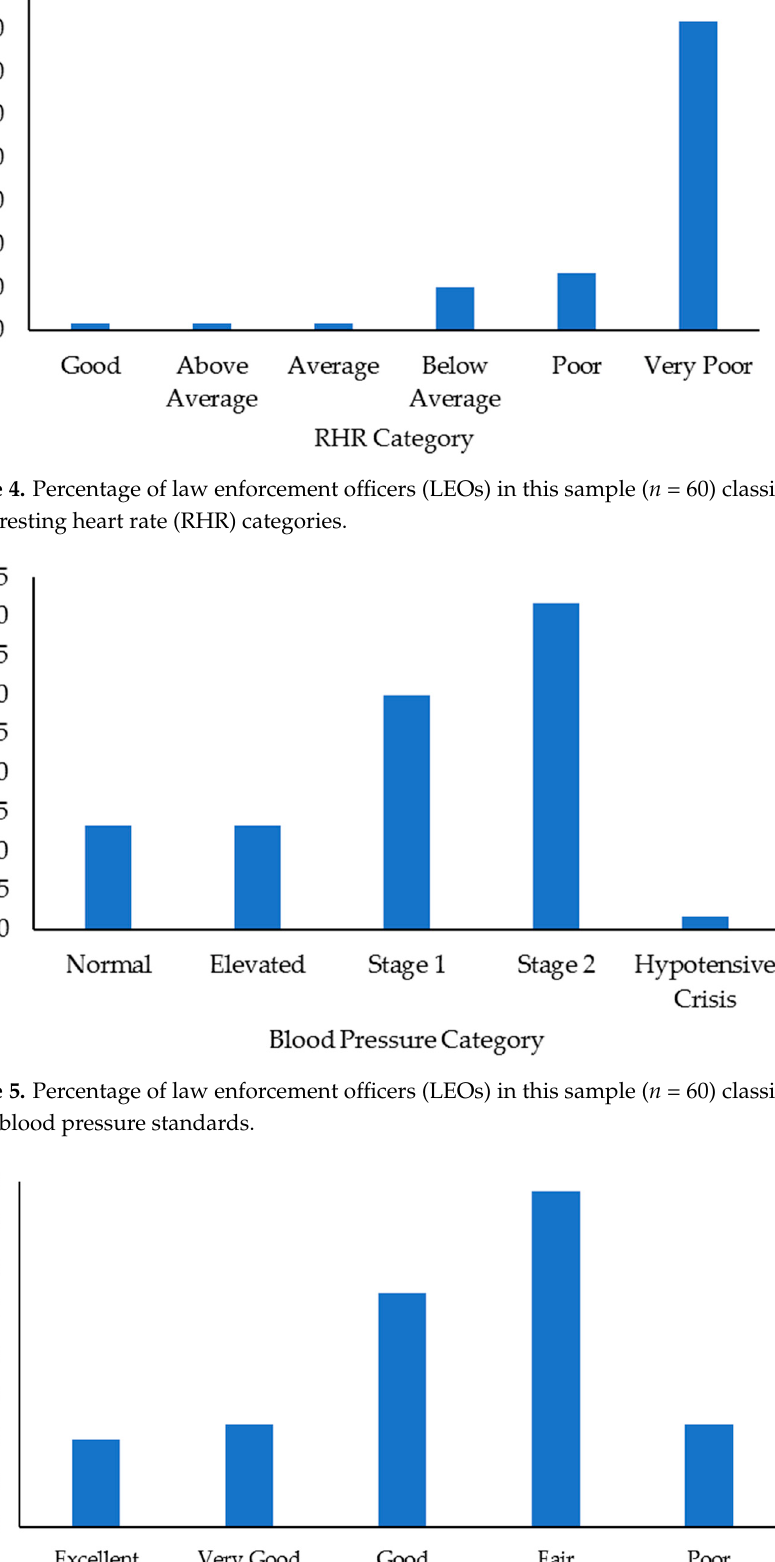
Figure 3. Percentage of law enforcement officers (LEOs) in this sample ( n = 60) classified according to the waist-to-hip ratio (WHR) cardiovascular disease risk categories.